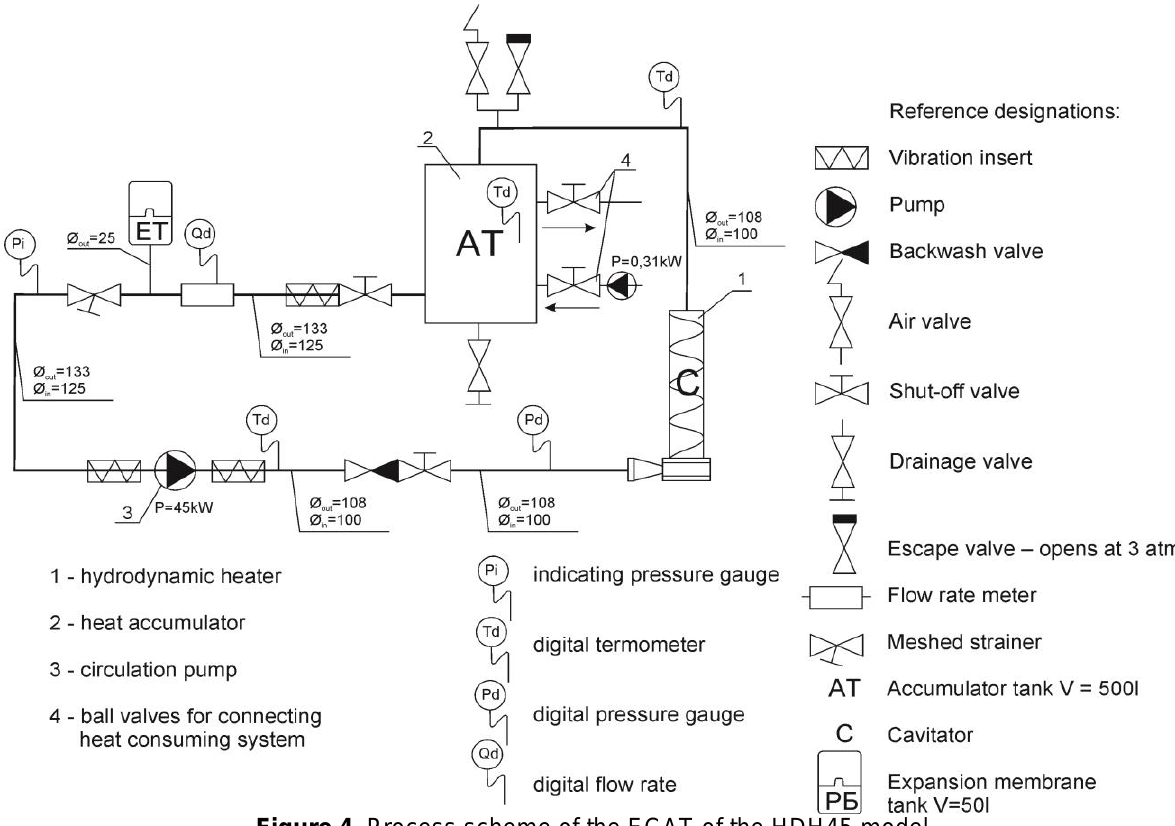
Figure 4. Process scheme of the ECAT of the HDH45 model